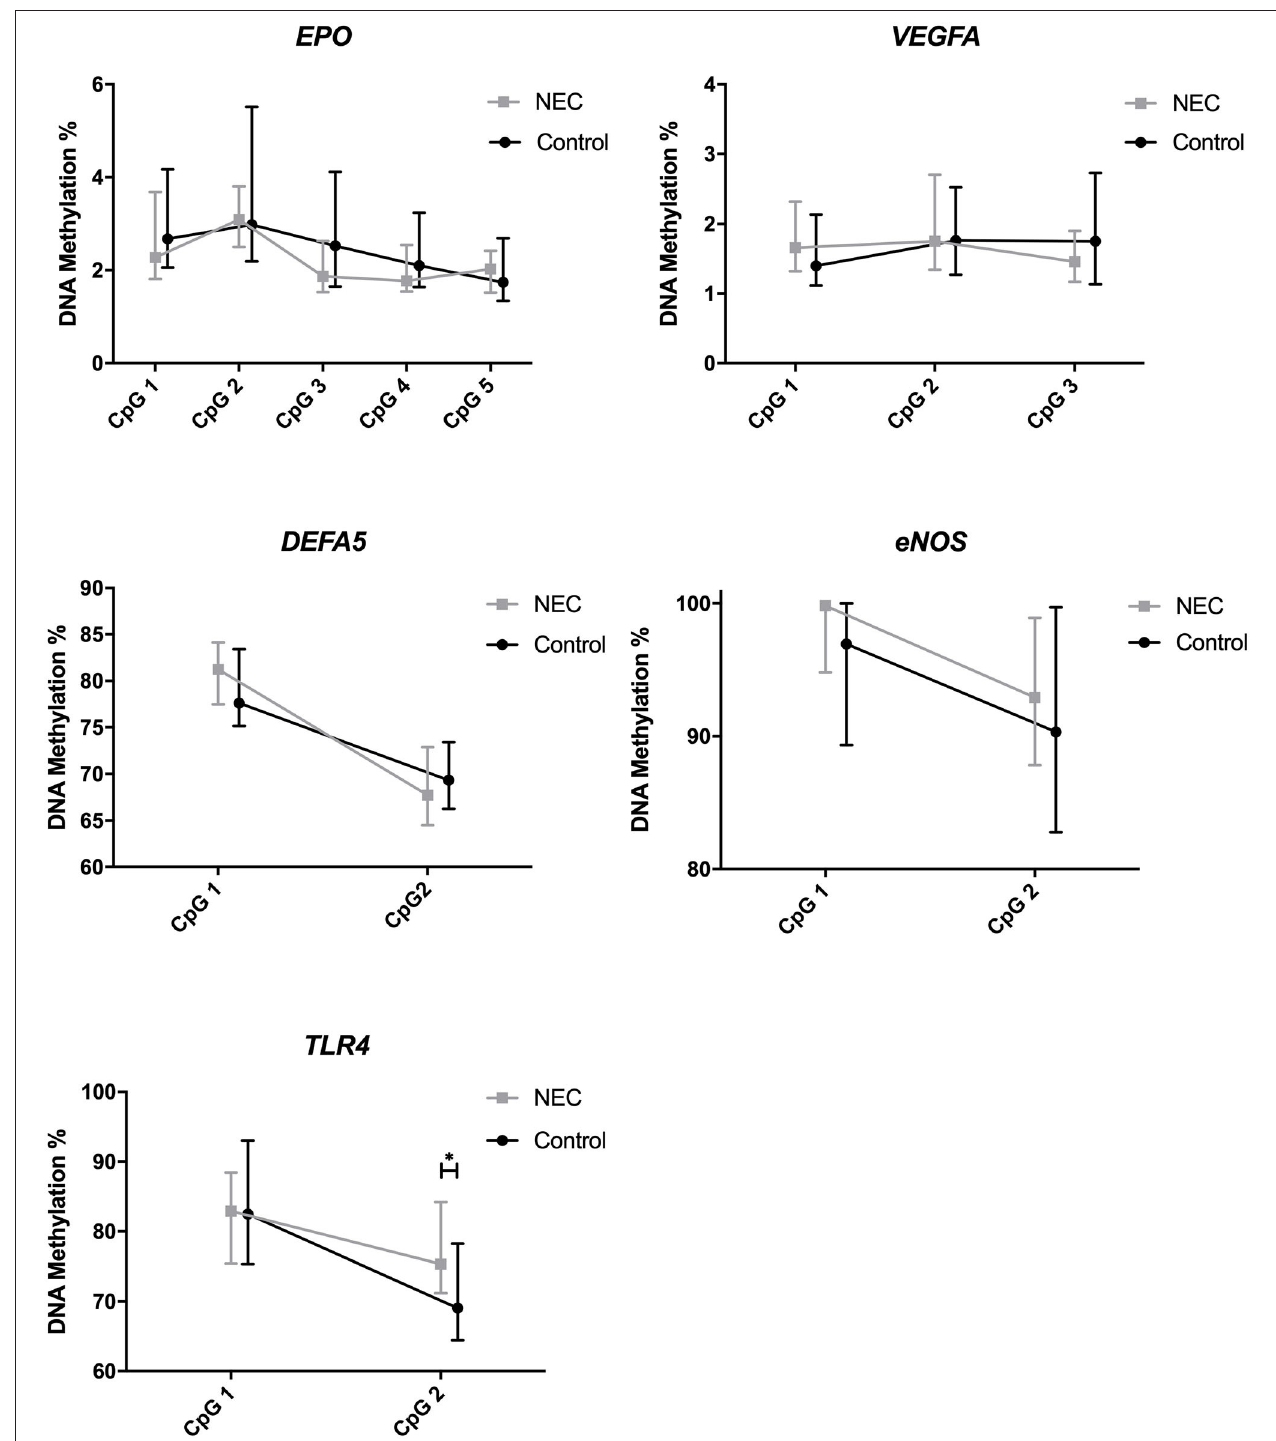
FIGURE 2 | DNA methylation of EPO , VEGFA , DEFA5 , ENOS , and TLR4, including individual CpG positions. Presented as median and IQR. * = P < 0.05. NEC, Necrotizing Enterocolitis. Our findings are in line with results from experimental NEC models, in which a lower VEGFA expression is reported as well as a decrease in the VEGFA protein in intestinal tissue